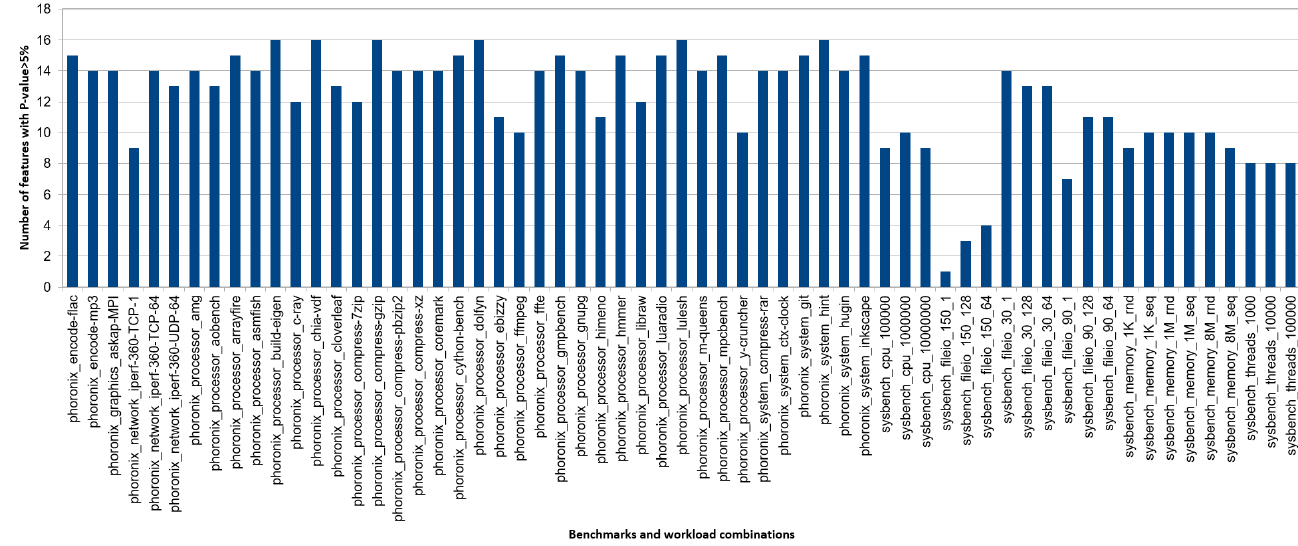
Figure 7. Number of features that surpass the 5% threshold of p -value for every